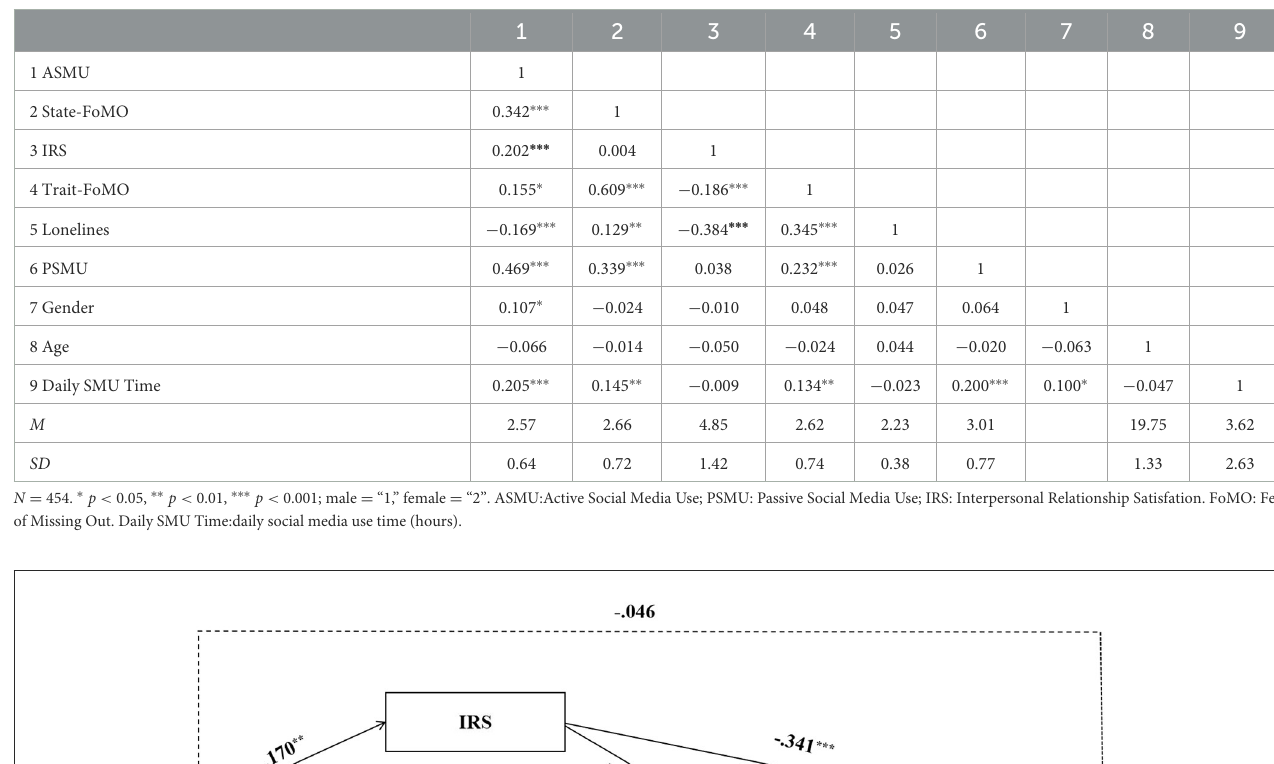
TABLE 1 Descriptive statistics and interrelations among observed variables.